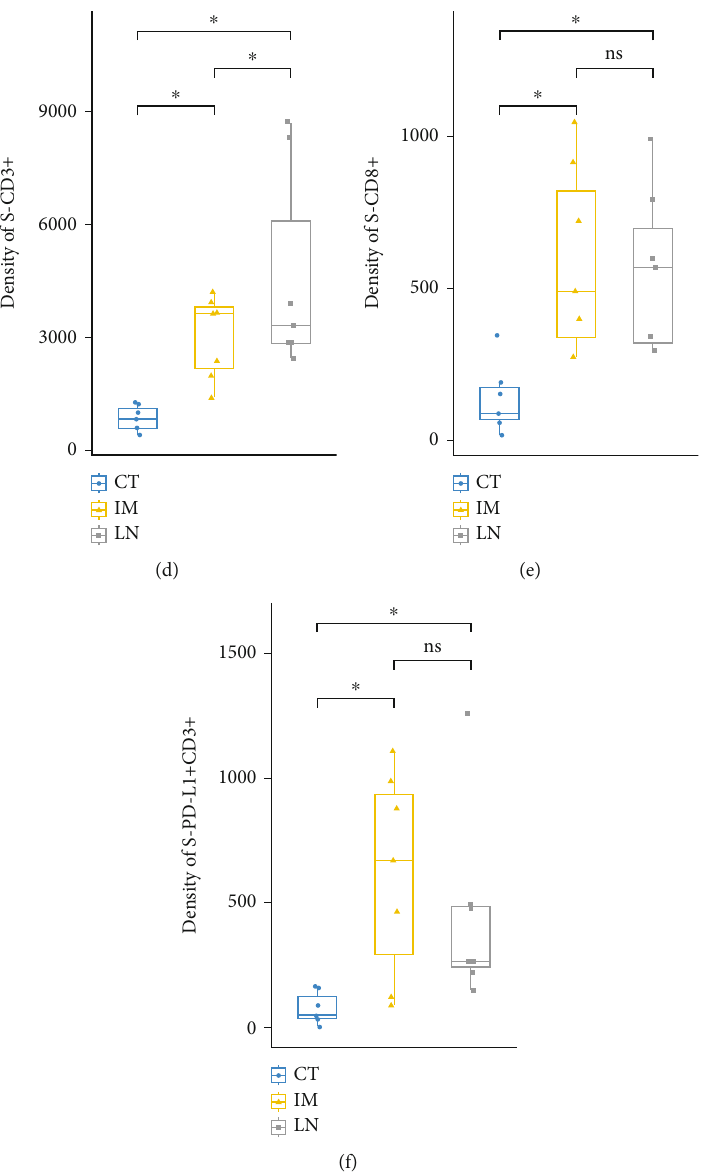
Figure 4: (a) Positron-emission tomography-computed tomography (PET/CT) imaging of the chest of a 46-year-old male patient with stage IIIA squamous cell lung cancer before and after the administration of 3 cycles of cisplatin/albumin-bound paclitaxel plus pembrolizumab. The pretreatment scan showed a primary tumor (PT) ( 3 : 3 ∗ 3 : 6 ∗ 6 : 8 cm; SUV max = 11 : 0 ) in the left upper lobe and enlarged subaortic lymph nodes (LN) ( 1 : 9 ∗ 2 : 9 cm; SUV max = 6 : 4 ) (upper arrow). A scan performed before surgery showed a decrease in size and